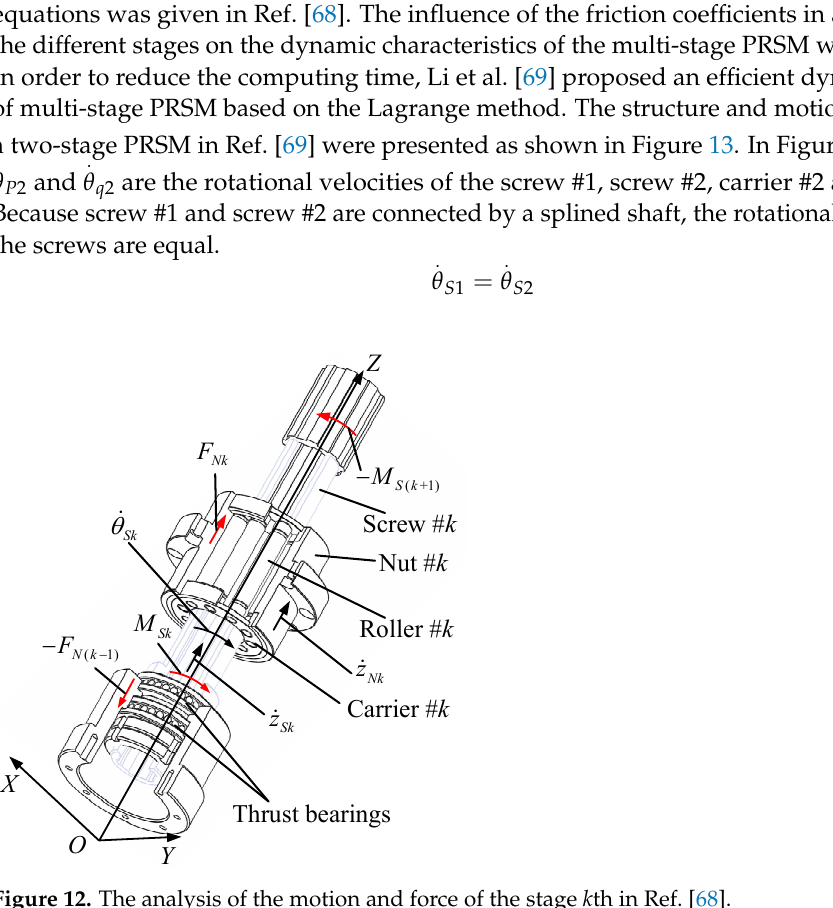
Figure 13. Structure and motion analysis of a two-stage planetary roller screw mechanism in Ref. [69].